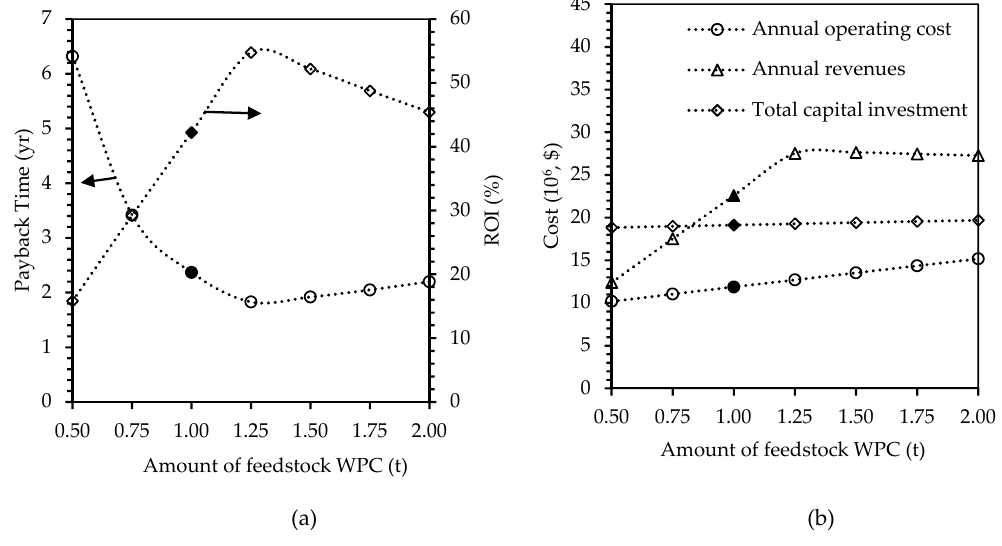
Figure 5. Effects of changing number of amounts of feedstock whey protein concentrate WPC, on ( a ) payback time in years and ROI in percent, and ( b ) annual operating cost, annual revenues, and total capital investment in U.S. dollars. Filled markers represent results of the base case scenario.